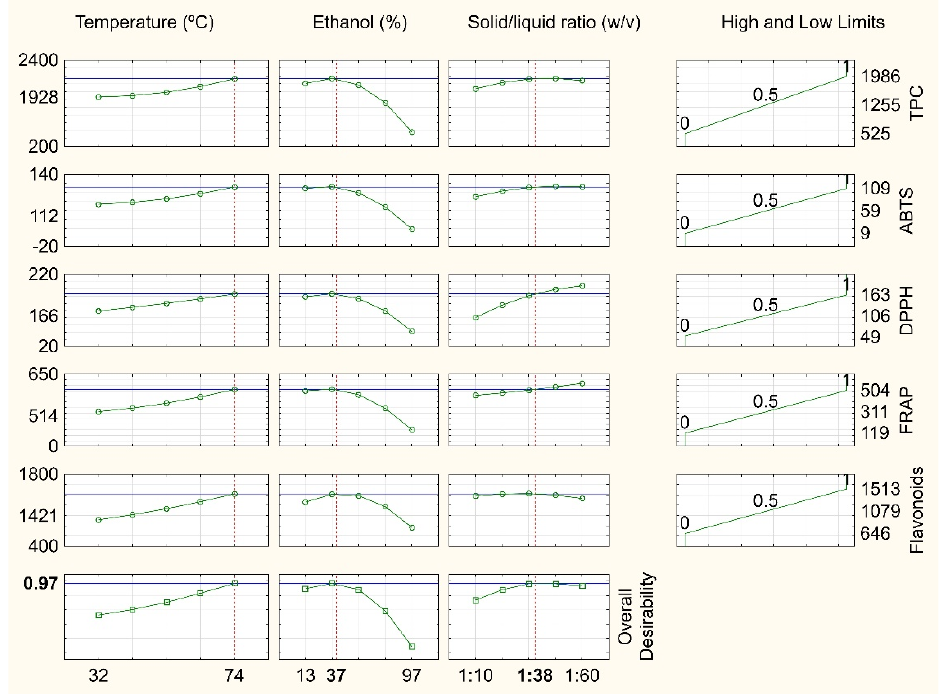
Figure 3. Profile of predicted values for individual and overall desirability for the extraction optimization. TPC—total phenolic compounds (mg GAE/100 g); TFC—total flavonoid compounds (mg RE/100 g); ATBS •+ —(µmol TE/g); DPPH • —(µmol TE/g); FRAP—(µmol Fe 2+